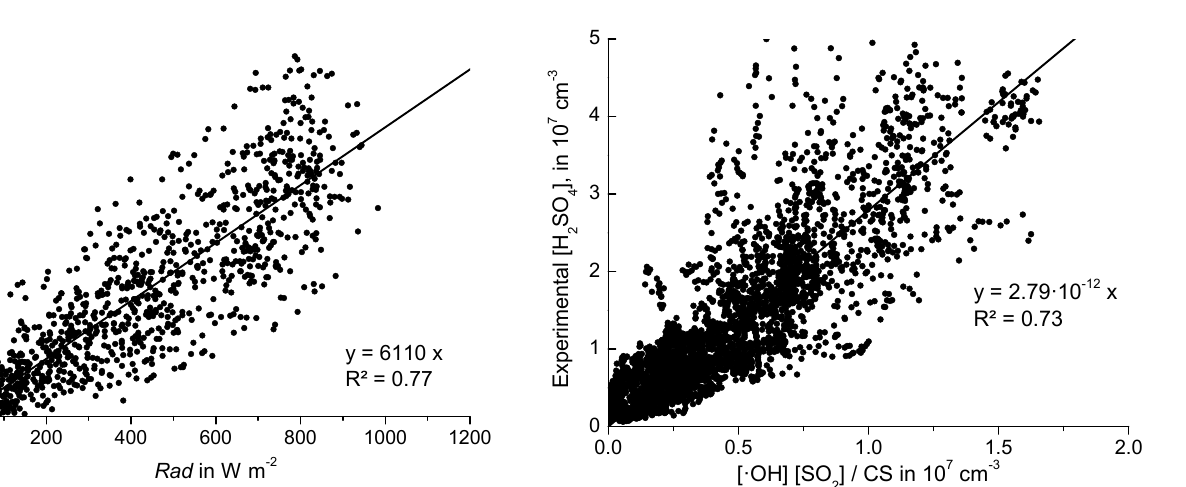
Figure 2. Definition of the H 2 SO 4 proxy based on the correlation of experimental and calculated values during EUCAARI 2008 (see also Eq.